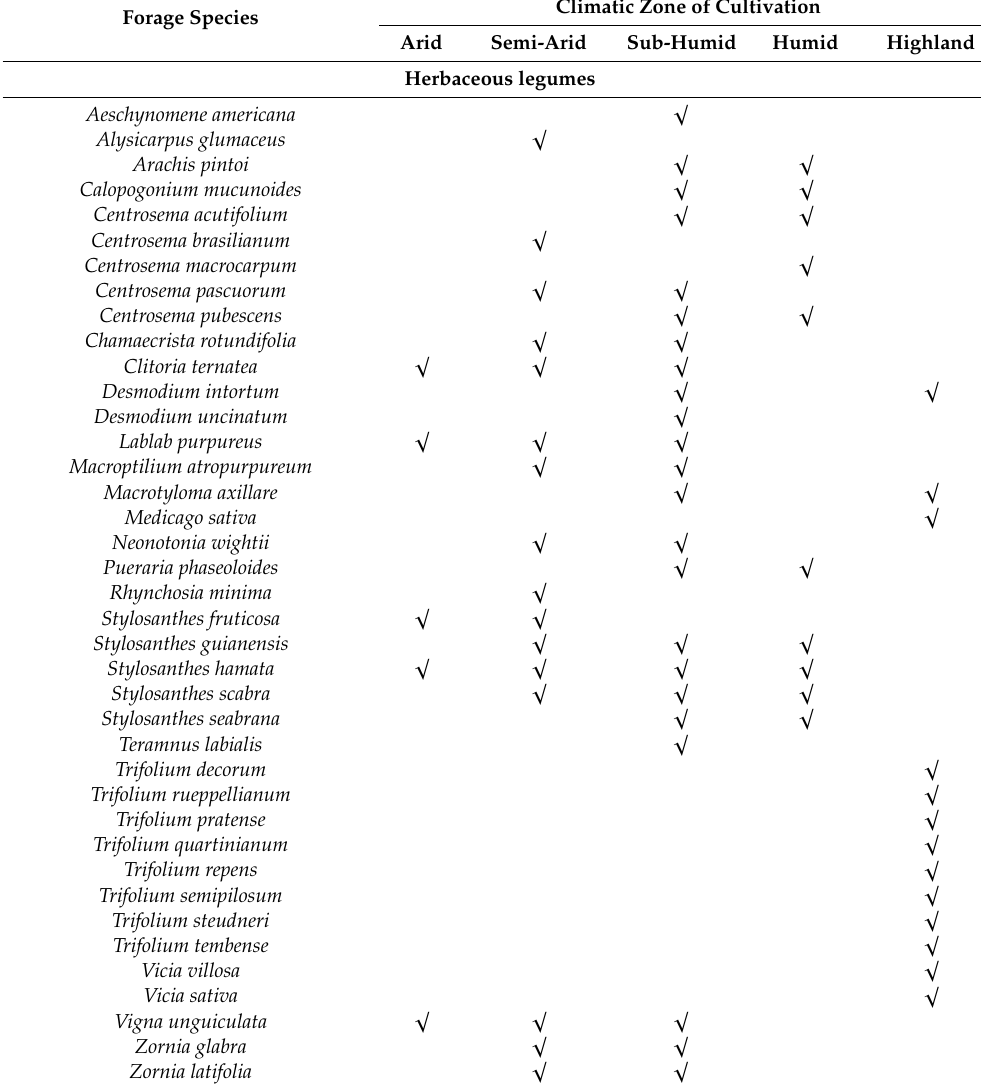
Table 1. Common tropical and sub-tropical forage species and climate zone suitability for cultivation. Climatic Zone of Cultivation Forage Species Arid